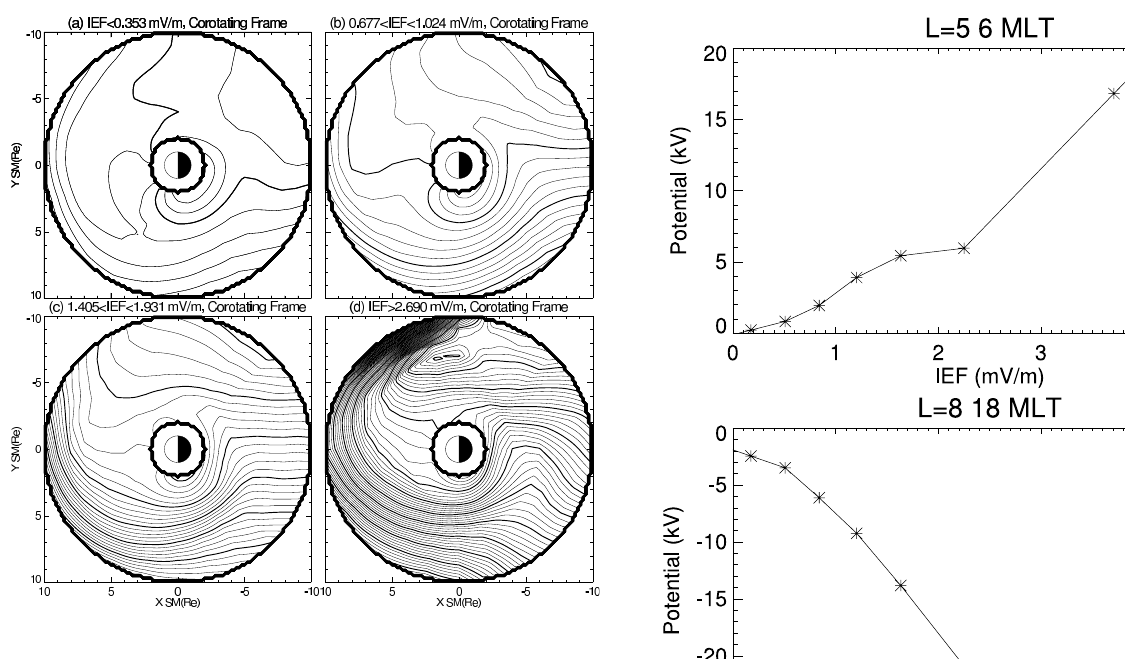
Fig. 4. Calculated electric potential patterns for four IEF ranges: IEF ranges correspond to first, third, fifth, and seventh ranges in this order from the lowest ranges. The results are shown in corotat- ing frame. Contour intervals are 1 and 5kV for thin and thick lines, respectively. Fig. 5. Interpolation and extrapolation of the electric potentials at